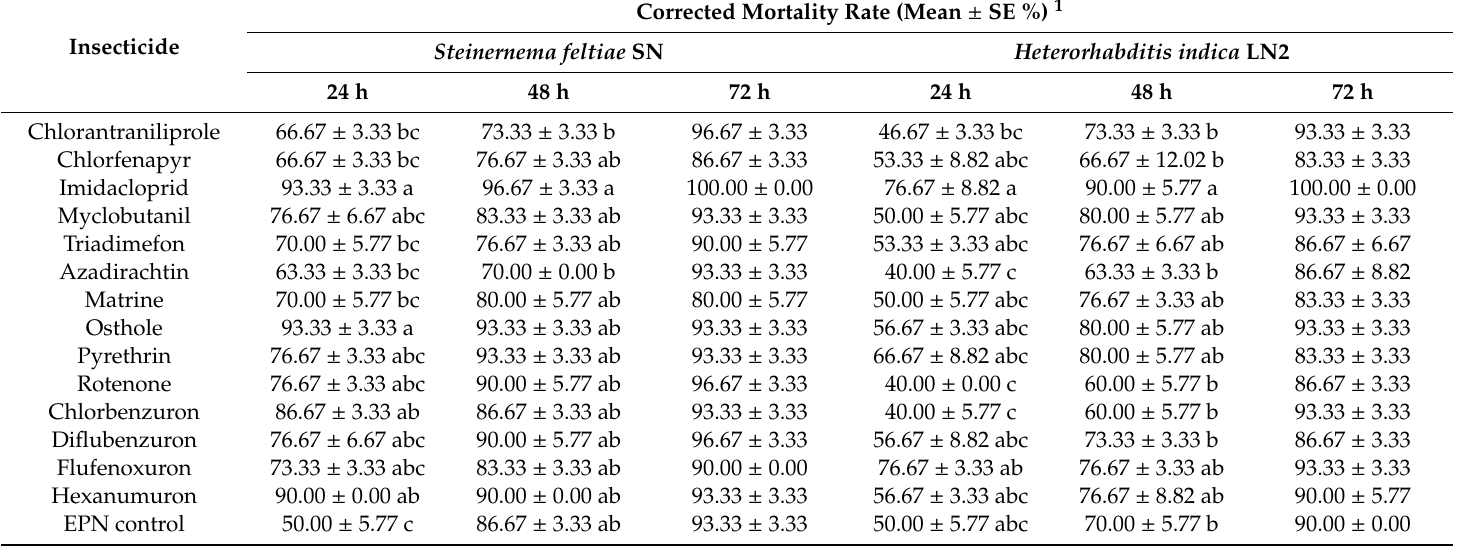
Table 2. The corrected mortality rate ( ± SE) of Bradysia odoriphaga larvae treated with di ff erent entomopathogenic nematode and insecticide combinations after 24, 48 and 72 h exposure to Steinernema feltiae SN and Heterorhabditis indica LN2 in di ff erent insecticides at the diluted recommended field concentration (1 / 10